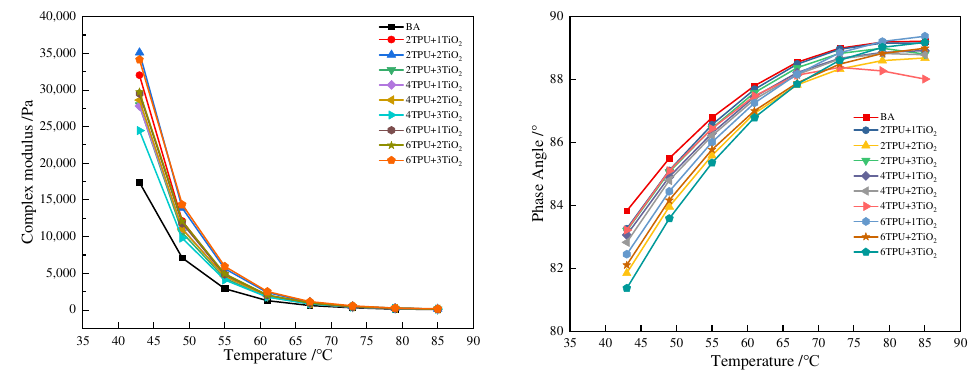
Figure 3. The curve of G* and δ with temperature. It can be seen from Figure 3 that as the temperature increases, the complex modulus of asphalt gradually decreases, and the phase angle gradually increases. This shows that with the increase of temperature, the high-temperature stability of asphalt will become pitch increases sequentially by 5.4°, 5.9°, 6.8°, 5.6°, 5.9°, 6.0°, 4.8°, 6.9°, 6.9°, and 7.8°. Alt- asphalt, it can be seen from Figure 3 that in the range of 43–67 °C, the phase angle, δ, of the modified asphalt was smaller than the phase angle, δ, of the base asphalt. In this tem- perature range, the modified asphalt has better resistance to deformation under load.